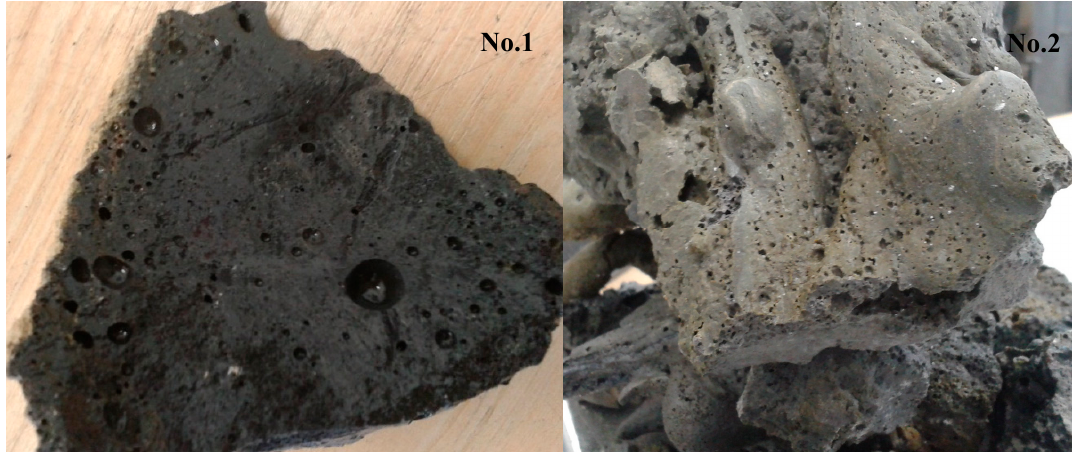
Figure 2. Examples of cooled down vitrified lignite fly ash samples no.1 and 2.